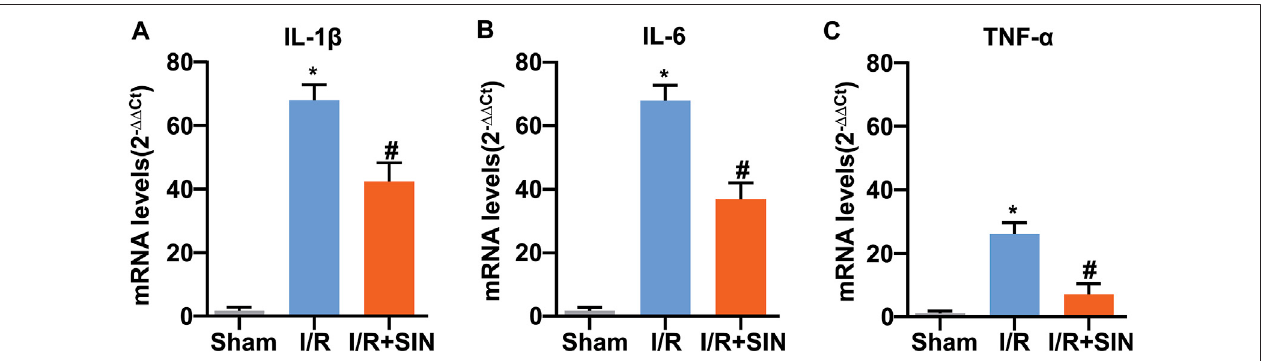
FIGURE 5 | Effect of SIN on in fl ammatory parameters in myocardial tissue of I/R mice. (A ‒ C) Quantitative analysis show that pretreatment with SIN prevented the MIRI-induced increase in theexpression levels ofIL-1 β (A) , IL-6 (B) , and TNF- α (C) mRNA in ischemic heart tissue ( n = 8,* p < 0.05 vs. sham, # p < 0.05 vs. I/R). Data are shown as means ±